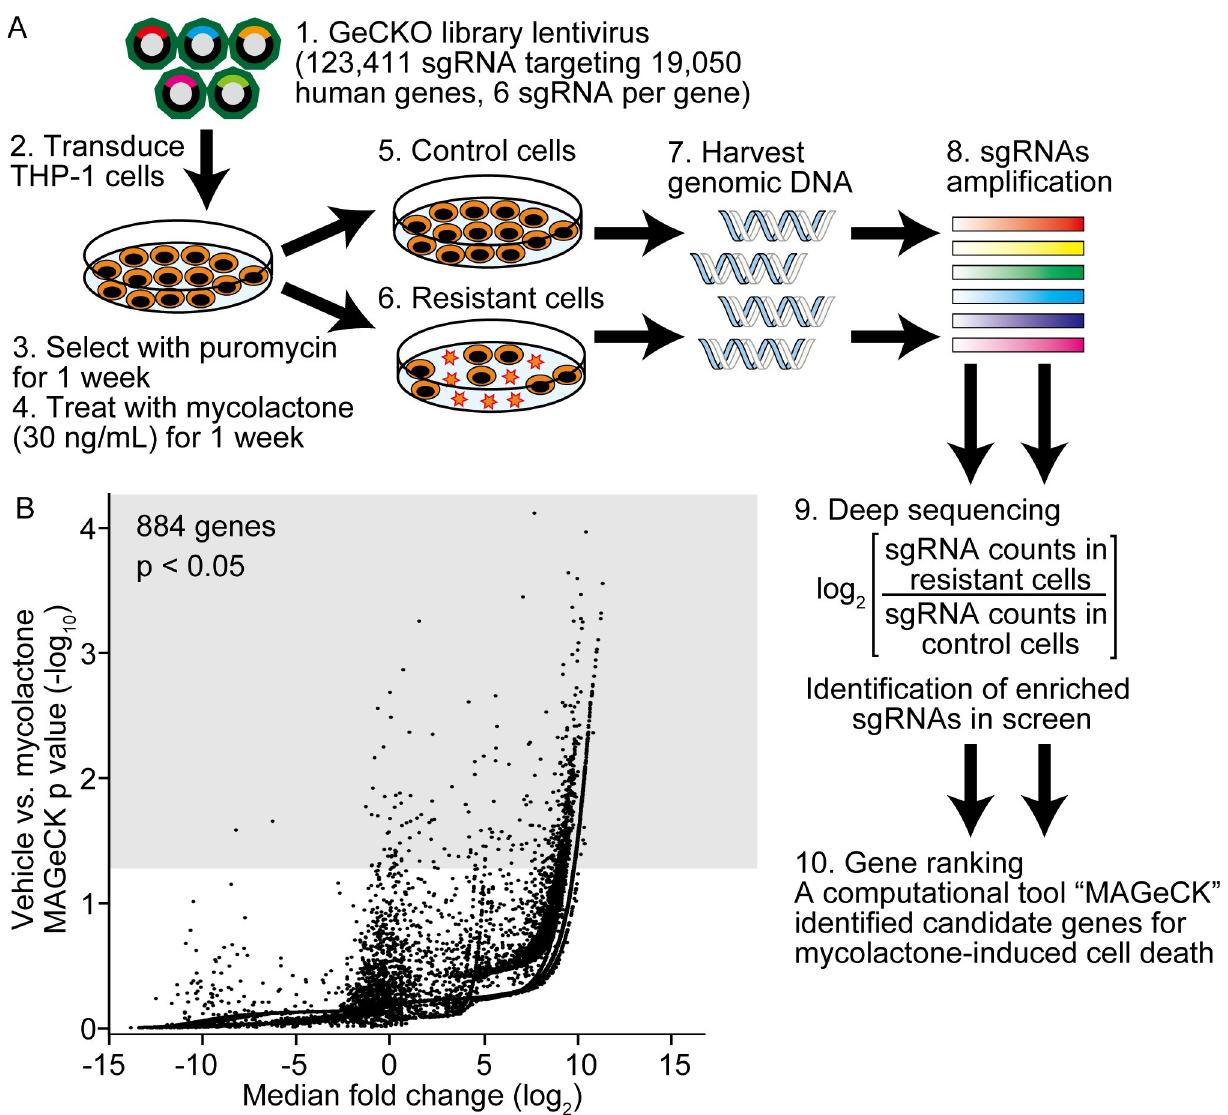
Fig 2. GeCKO screening identified essential factors meditating mycolactone-induced cell death. (A) Schematic representation of the GeCKO screening procedure (see Methods for details). (B) Volcano plot showing genes associated with mycolactone-induced cell death. The plot displays the log 2 fold changes of the mean sgRNA counts (sgRNA count in resistant cells / sgRNA count in control cells) on the x-axis and − log10 p-values from MAGeCK RRA comparisons on the y-axis. Genes with p < 0.05 are shown in the gray area of the